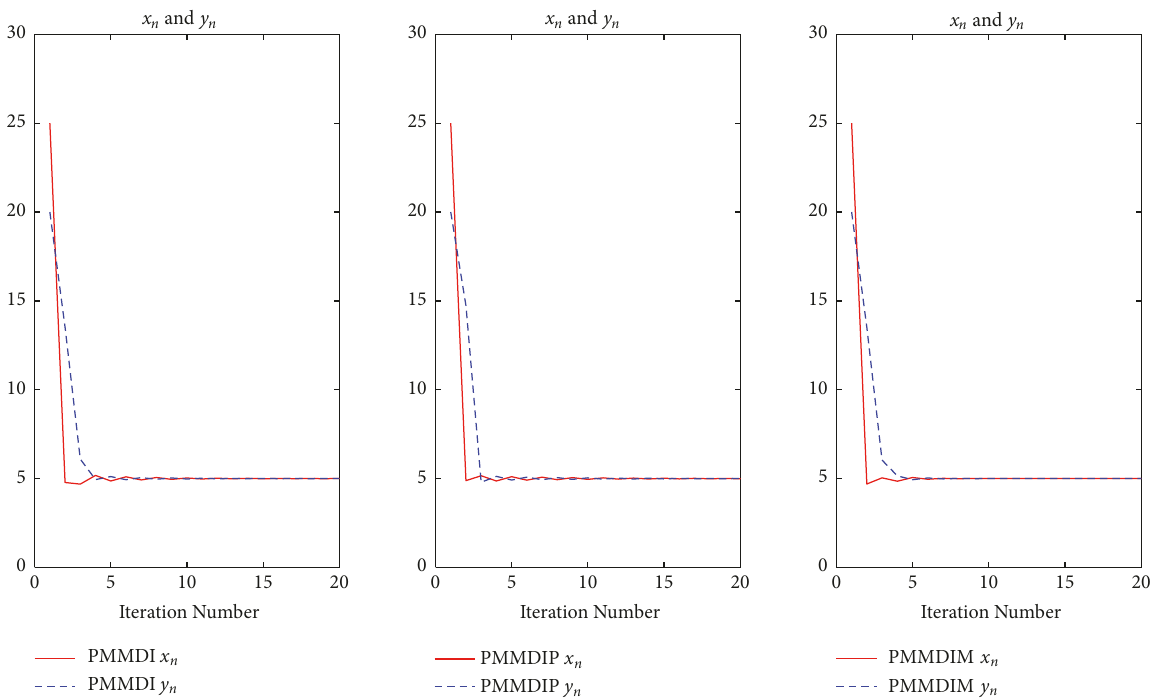
Figure 1: Iterative solutions of (PMMDI), (PMMDIP), and (PMMDIM).